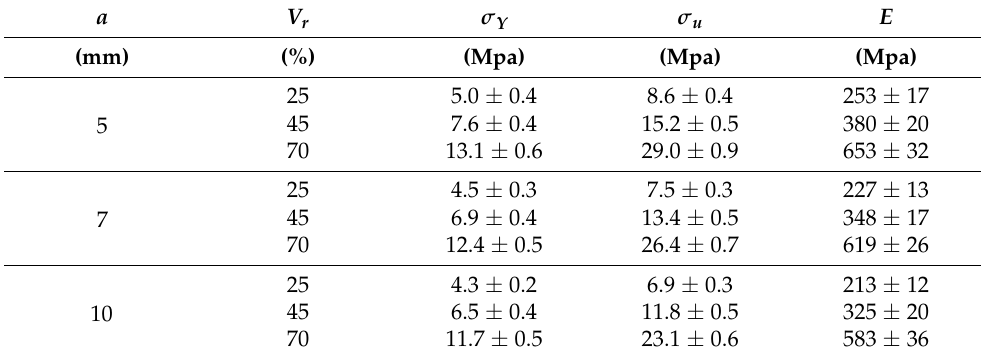
Table 3. Average values including their standard deviations of yield strength σ Y , ultimate limit strength σ u , and Young’s modulus